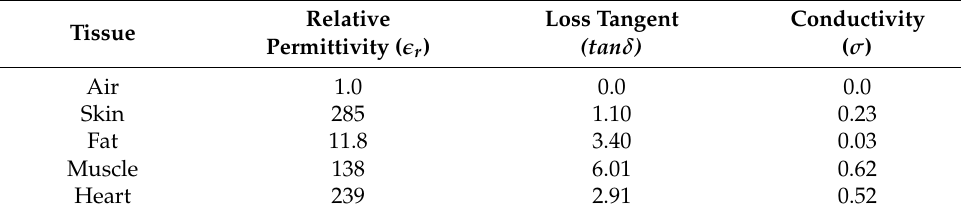
Table 2. The biological tissues’ dielectric characteristics at 13.56 MHz [26].